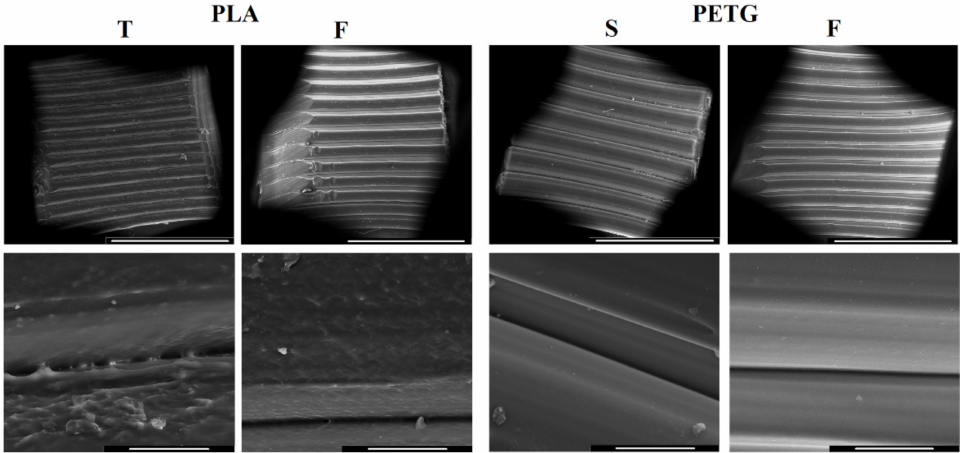
Figure 11. SEM image of the 3D-printed samples showing the morphology for the samples printed with 0.4 mm layer thickness (upper row magnification 100 × , scale bar 1 mm; bottom row magnifica- tion 1000 × , scale bar 100 µ